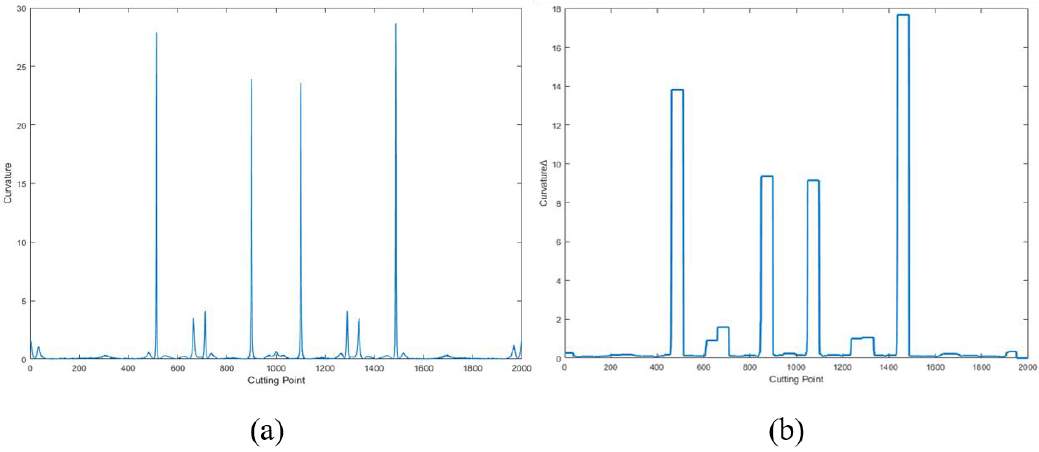
Figure 9. ( a ) Curvature and ( b ) curvature variation of trident shape.